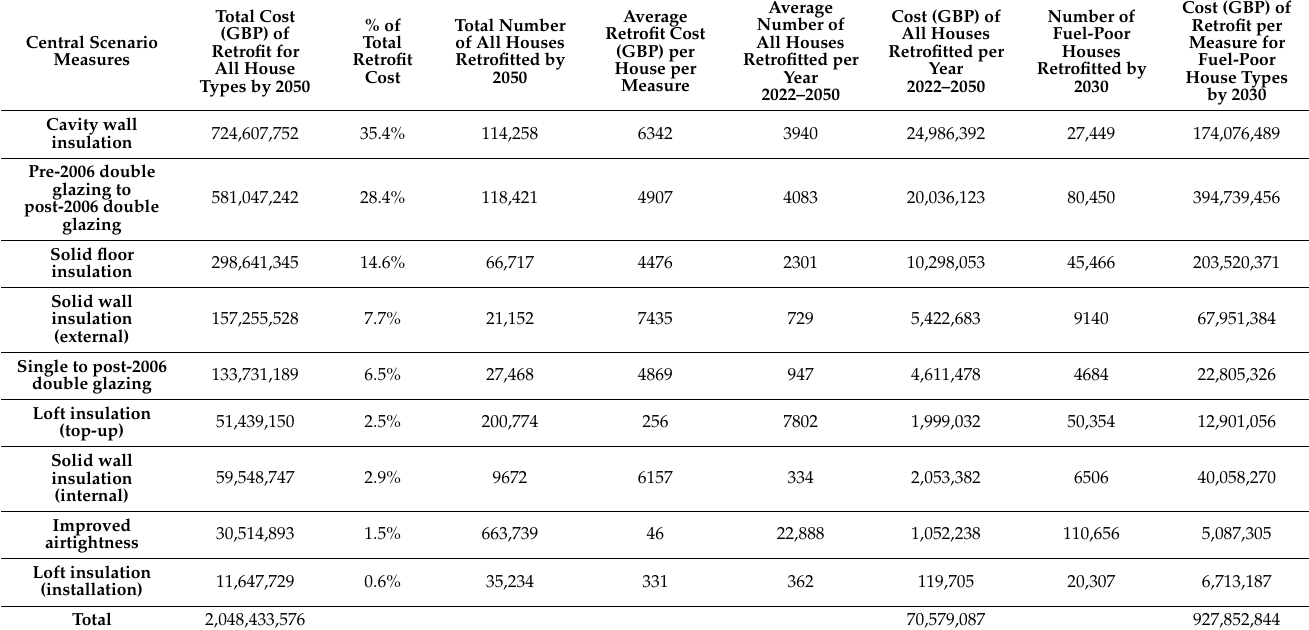
Table 5. Retrofit cost breakdown for the Central